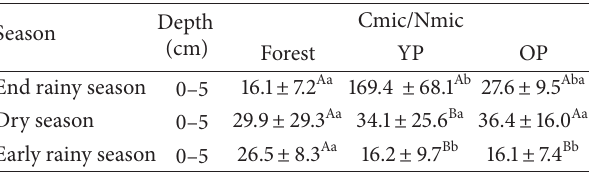
Table 6: Relationship between soil microbial carbon and soil microbial nitrogen in the forest and pastures.